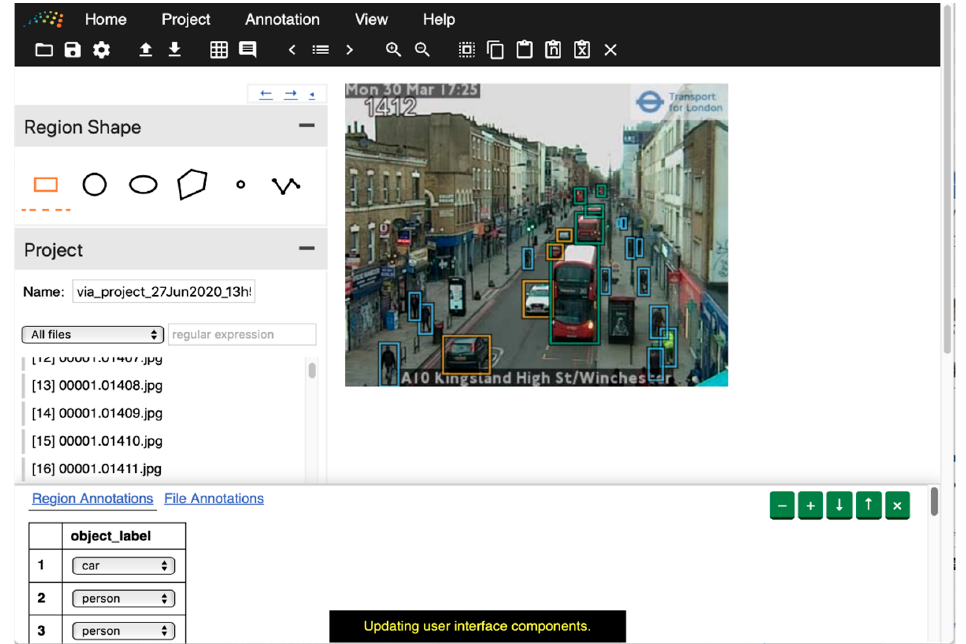
Figure 4. Example of the VGG Image Annotator tool being used to label objects on an image of a London street (TfL open data): orange box: car, blue box: person, green box: bus. Two groups of volunteers from the Office for National Statistics (ONS) helped label